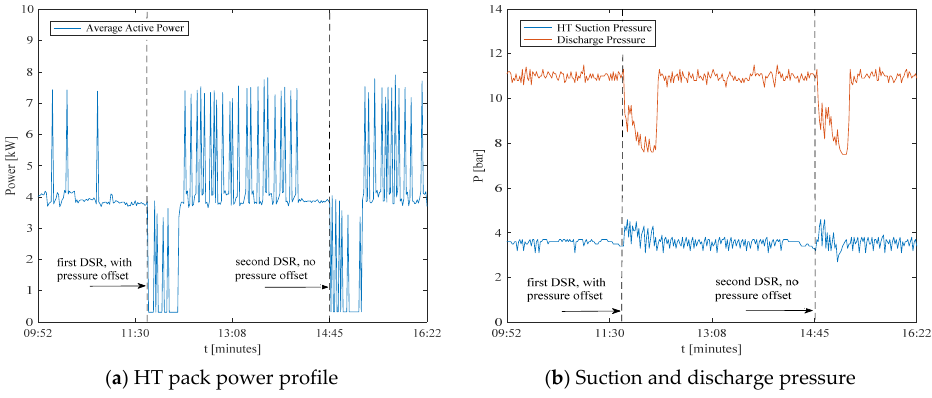
Figure 5. ( a ) Active power readings (HT compressors); ( b ) Suction and discharge pressure profiles (HT). Full system shut-down for 30 s with 12 out of the 13 cases being switched off for 30 min, two DSR events are triggered at 11:45 and 14:45.